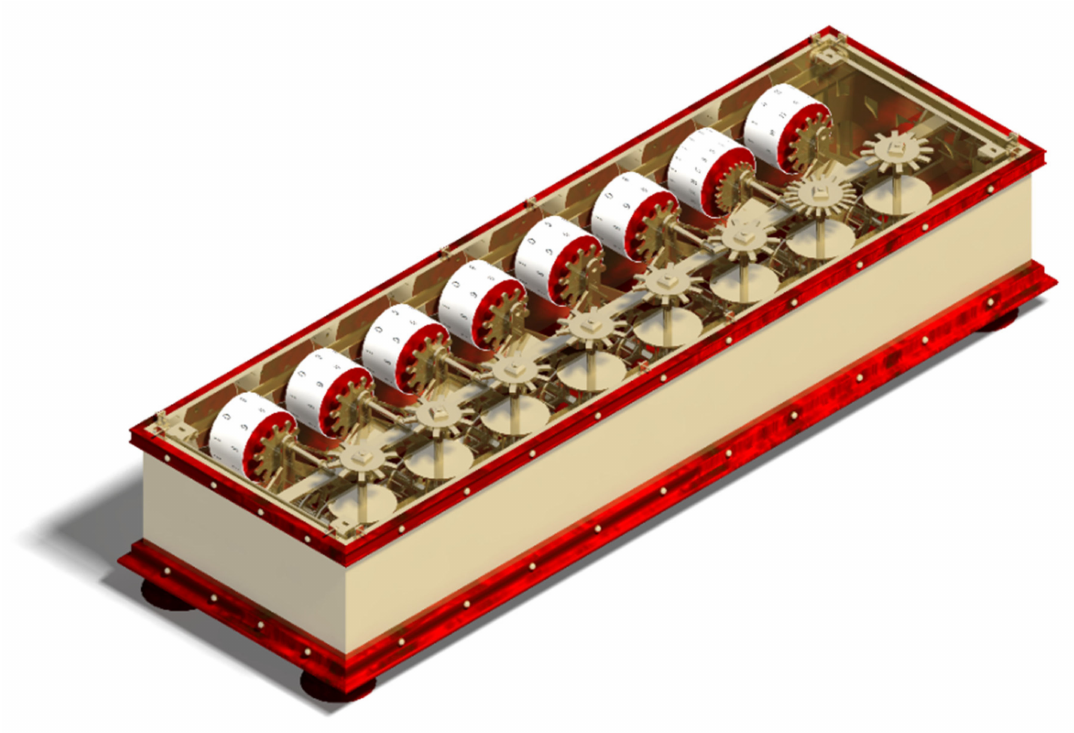
Figure 25. Axonometric view of the Pascaline without its lid.